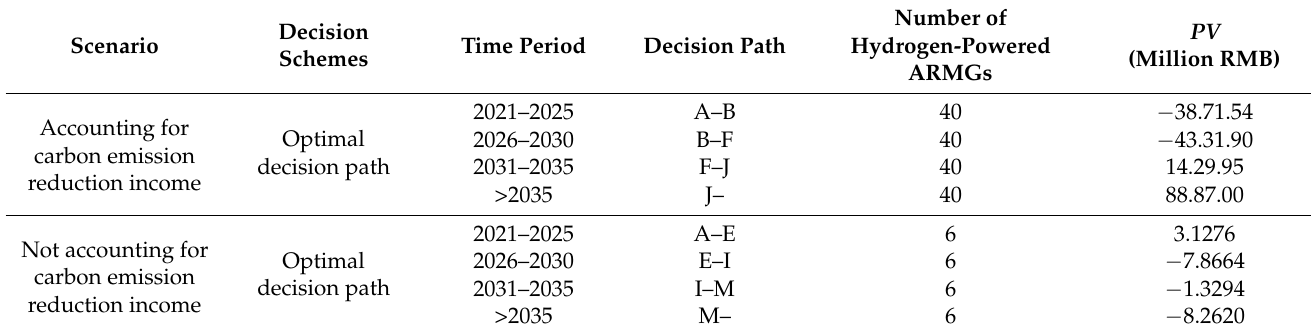
Table 7. Investment decision result of Qingdao Port ARMGs’ low-carbon transition under the change of accounting for carbon emission reduction